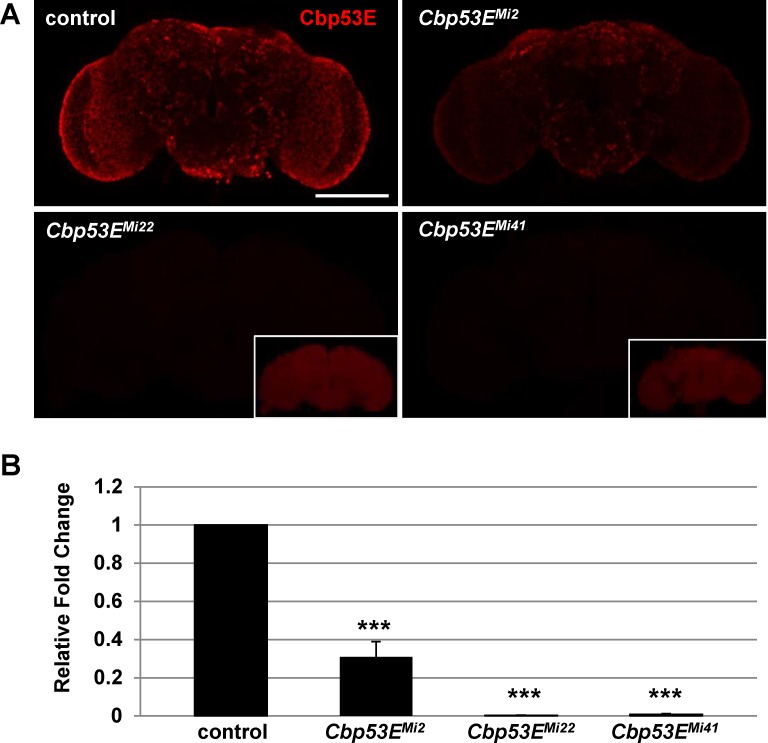
Generation of novel loss of function Cbp53E alleles.A) A Minos transposable element in the 3′ portion of the CBP53E locus was mobilized to generate 3 new alleles with reduced Cbp53E expression in the adult brain. Cbp53E
Mi2 shows residual Cbp53E, while alleles Cbp53E
Mi22 and Cbp53E
Mi41 are complete nulls. Insets show the same image with increased detector gain settings. Scale bar is 100μm. B) Quantitative RT-PCR of Cbp53E mRNA levels normalized to GAPDH2 from the indicated genotypes and reported as the relative fold change to control levels. *** p<0.001.